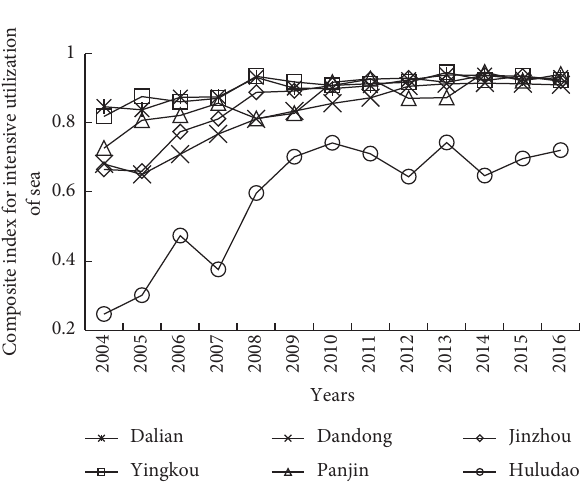
Figure 3: Composite index for intensive sea